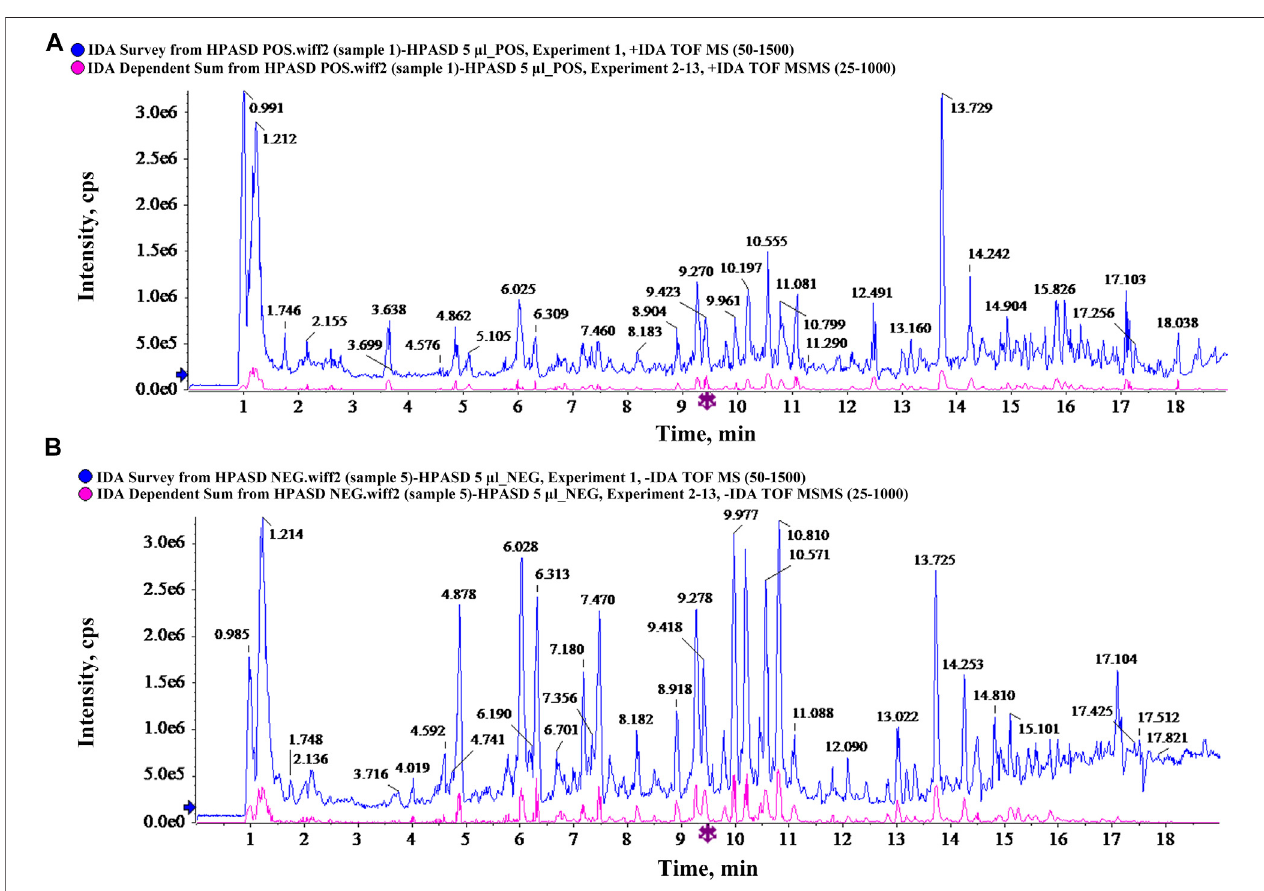
FIGURE 2 | Characteristics of chemical components in HPASD by UPLC-Q-TOF/MS analysis. (A) Base peak chromatograms of HPASD in positive ion mode (B) Base peak chromatograms of HPASD in negative ion mode.